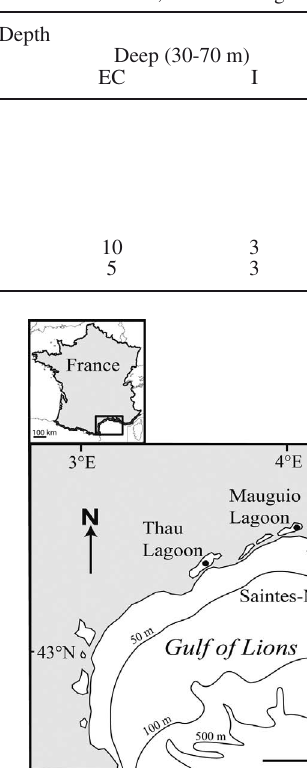
Table 1. – Numbers of left sagittae of Solea solea analysed for elemental composition (EC) and isotopic fingerprint (I) from different sites, seasons and depths in the NW Mediterranean Sea. TL, total fish length.